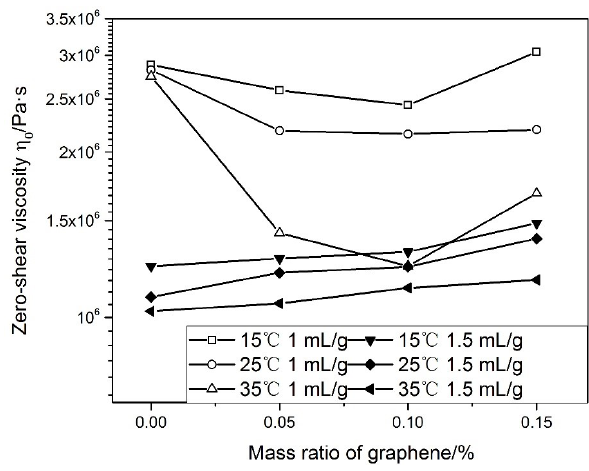
Figure 5: ZSV vs. mass ratio for graphene at different